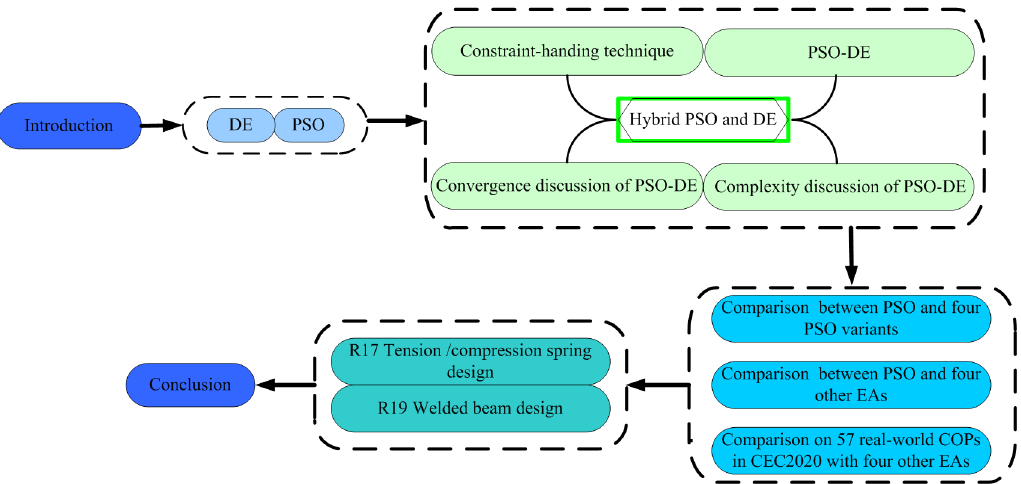
Figure 1. Graphical abstract of this